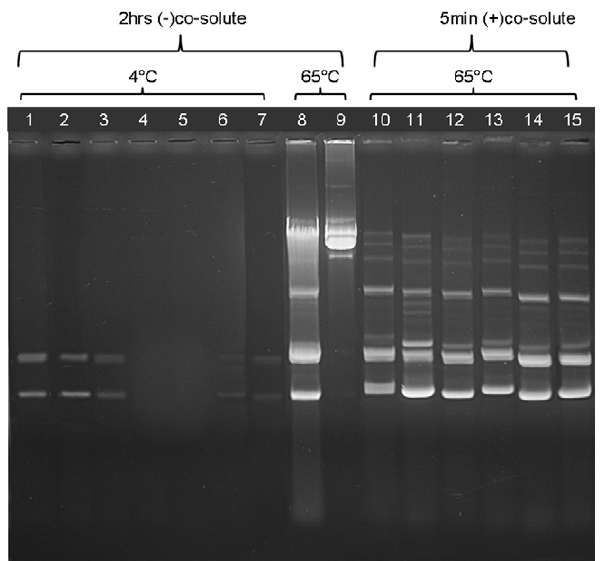
Figure 1. Elevated temperatures and osmolytes increase the efficiency of plasmid DNA extraction by NIDs. Extractions of either pUC19 (lanes 1–8 and 10–15) or pCYPAC3 plasmids (lane 9) were carried out. Transformed DH5 a cells were grown in 1.5 ml LB cultures and resuspended in 150 m l 50 mM Tris pH 8, 10 mM EDTA with or without co-solutes. 500 m g/ml lysozyme was also added, and the cells were incubated as specified below. Salt concentrations were adjusted to 0.5 M NaCl in all extracts, except the ones loaded in lanes 10 and 12– 15. Extracts were cleared by centrifugation, and precipitated with 150 m l isopropanol. DNA pellets were dissolved in 40 m l TE buffer, 40 m g/ml RNase A. 10 m l aliquots of the solutions containing either the pCYPAC3 (lane 9) or pUC19 plasmids (all other lanes) were loaded on the gel. Exposure times and temperatures of extraction are shown above the lanes. For lanes 1–9, extraction with the indicated NID was done in the absence of co-solutes. For lanes 10–15, the included co-solute is indicated. Lane 1: 0.5% IGEPAL CA-630. Lane 2: 0.5% TX-100. Lane 3: